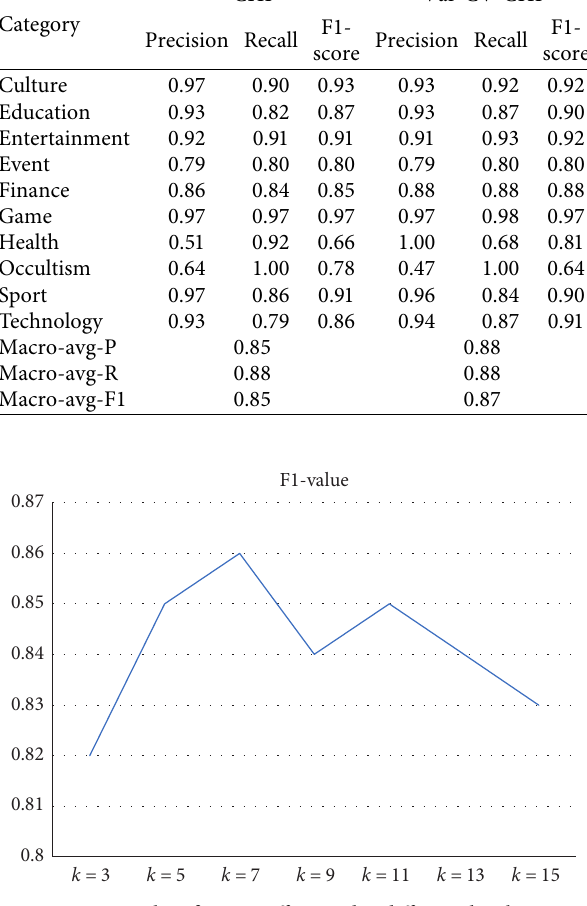
Figure 2: Classification effect under different k